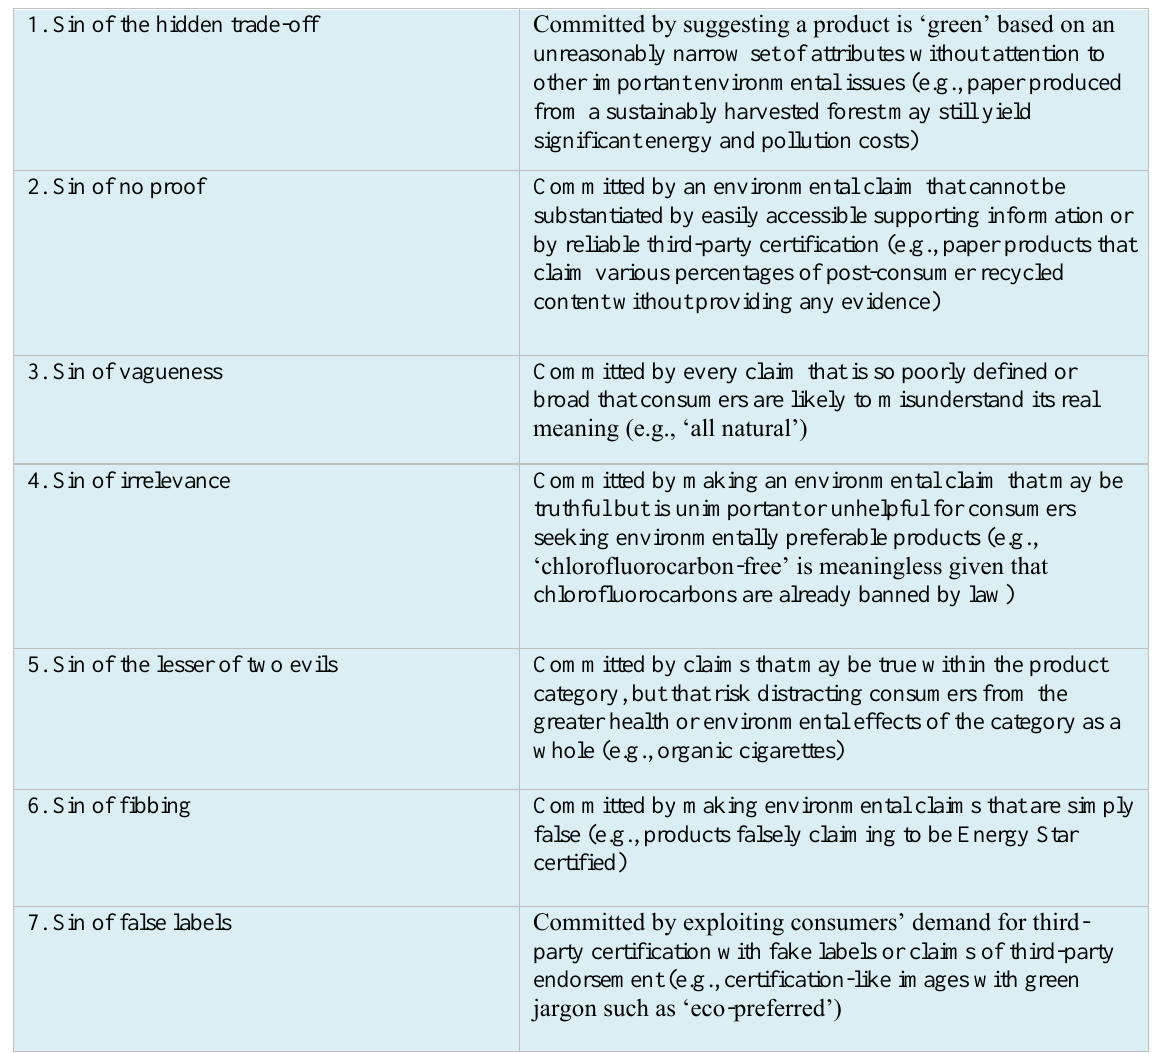
Table 1: The Seven Sins of Greenwashing